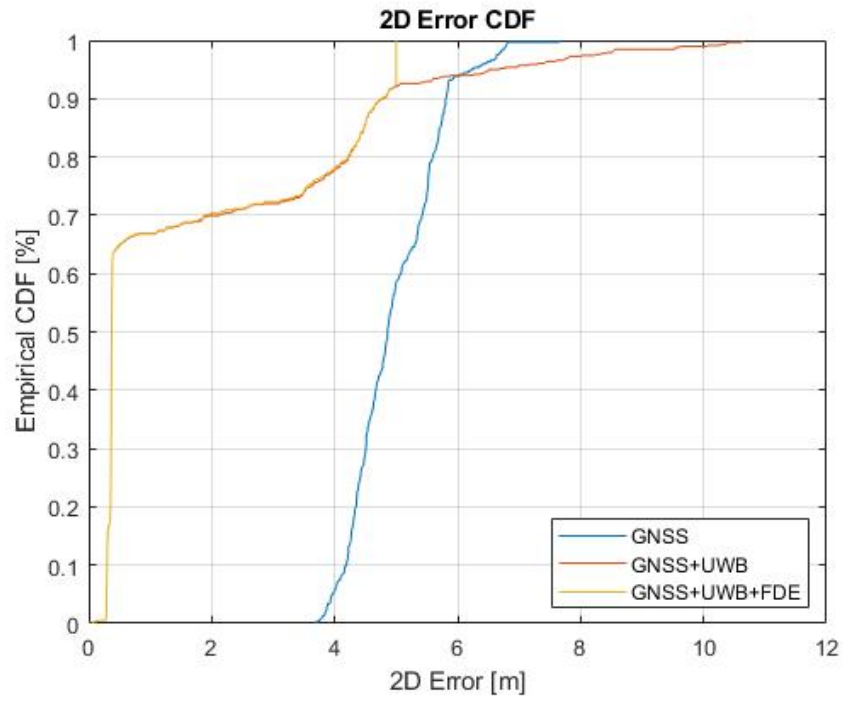
Figure 10. Comparison of the 2D error cumulative distribution functions (round 5).